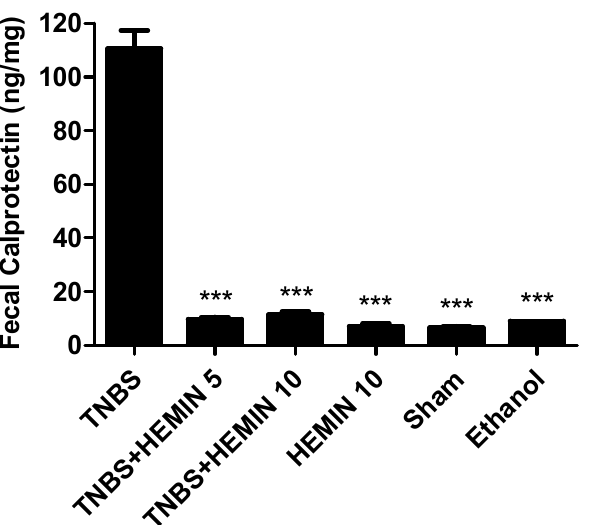
Figure 2. Effect of hemin treatment on fecal calprotectin in the IBD. Legend: One-way ANOVA for multiple comparisons and Tukey’s post hoc test. *** p < 0.001; compared with TNBS group. Fecal hemoglobin was measured and compared between all the experimental groups (Figure 3). This marker allowed for an evaluation of the intensity of hemorrhagic focus and the impact of hemin treatment. The mice in the TNBS group presented a more severe presence of blood in feces compared with the HEMIN 10 (6.93 ± 2.10 μ mol/g feces vs. 1.17 ± 0.12 μ mol/g feces, p < 0.001), sham (6.93 ± 2.10 μ mol/g feces vs. 1.70 ± 0.20 μ mol/g feces, p < 0.001), and ethanol (6.93 ± 2.10 μ mol/g feces vs. 2.05 ± 0.50 μ mol/g feces, p < 0.001) control groups. Hemin treatment demonstrated a statistically significant influence on the intensity of hemorrhagic focus as a significant difference in fecal hemoglobin was ob- served between the TNBS group, namely TNBS + HEMIN 5 (6.93 ± 2.10 μ mol/g feces vs. 2.27 ± 0.54 μ mol/g feces, p < 0.001), and TNBS + HEMIN 10 (6.93 ± 2.10 μ mol/g feces vs. 2.43 ± 0.41 μ mol/g feces, p < 0.001). However, the differences between dosages of hemin were not statistically significant.